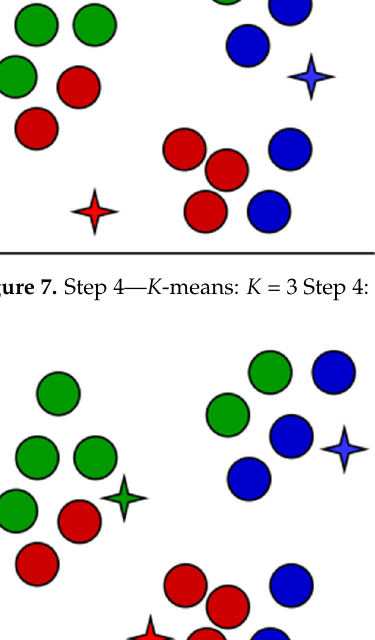
8 of 23 Figure 5. Step 2— K ‐ means: K = 3 Step 2: Initialize 3 centeroids.